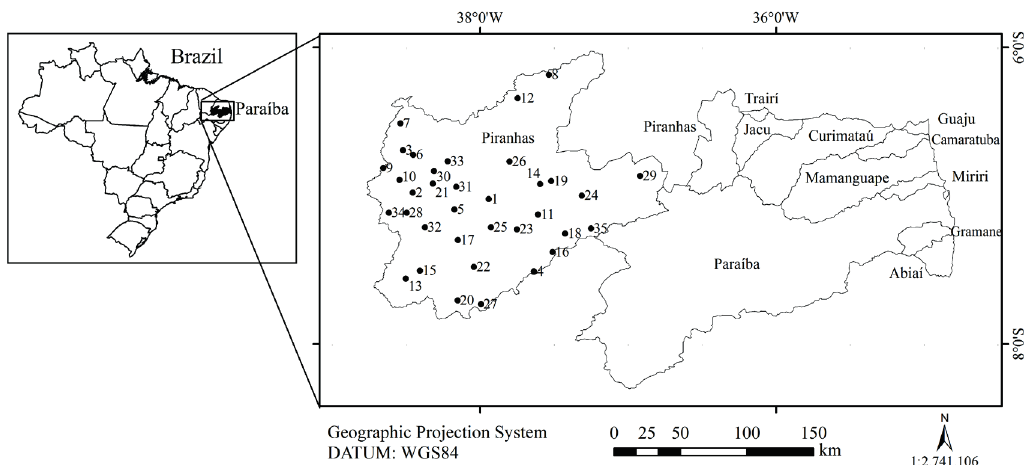
Fig. 1 Study region with the raingauge stations and water basins of Paraiba